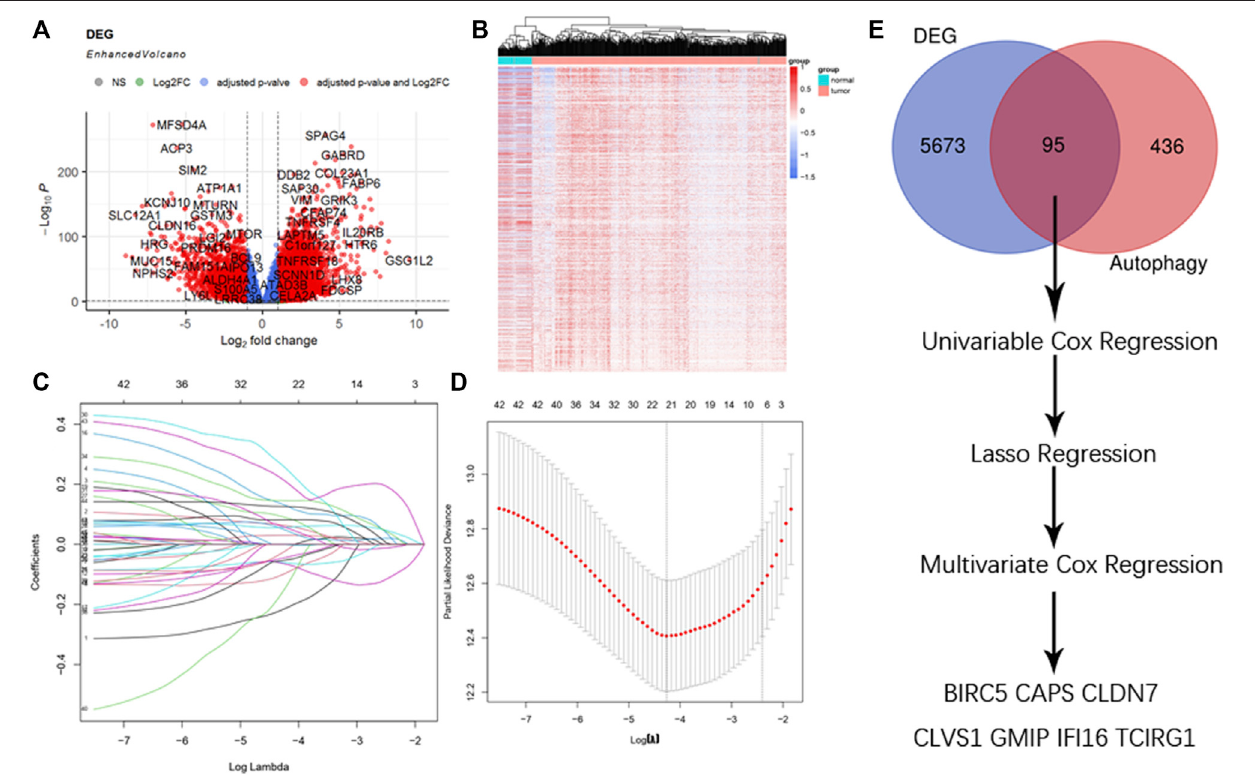
FIGURE 1 | Selection of DEGs. (A) Enhanced volcano plot of DEGs when comparing ccRCC with normal tissue. Red nodes represented genes with |log 2 FC| ≥ 1 andadjusted p < 0.05,bluenodesrepresentedgeneswithadjusted p < 0.05only,andgreynodesrepresentedgenesthatwereneithereligibleinconditionsofadjusted p valuenor|log2FC|. (B) HeatmapofDEGsinccRCC. (C) Lassocoef fi cientspro fi lesof95genessigni fi cantinunivariatecoxregression. (D) Lassoregressionobtained21 prognostic genes using minimum lambda value. (E) Selecting procedure of DEGs, venn gram showed 95 genes in the intersection of 5,768 DEGs and 531